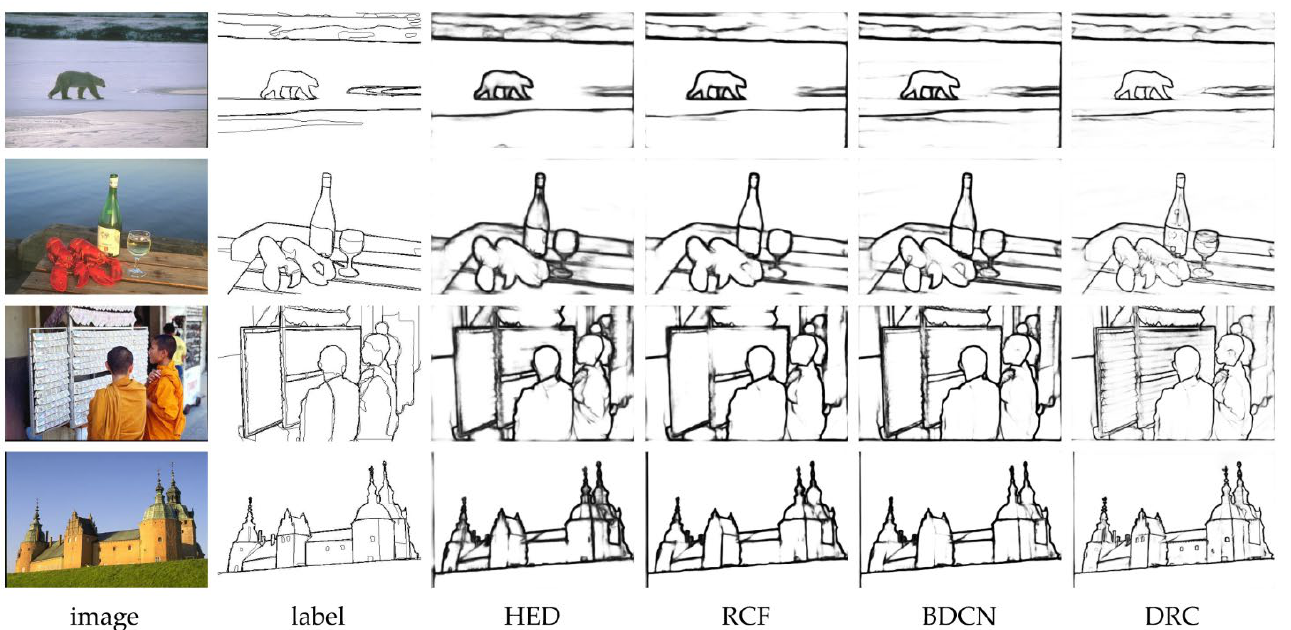
Figure 12. Results of BSDS500 dataset using stat-of-the-art DCNNs-based edge detection networks reproduced by our codes. Table 5. Evaluation metrics of our reproduced results and official reported results on the BSDS500 test set. Model